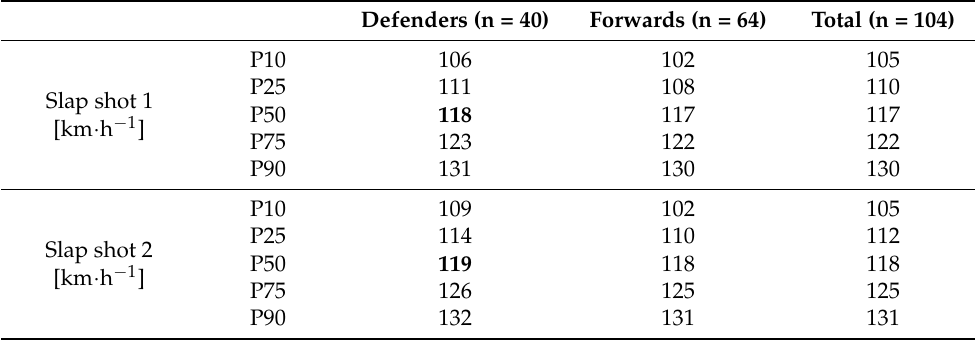
Table 5. Percentile data of shot performance after test by playing position. Based on the 50th percentile, performance maxima marked in